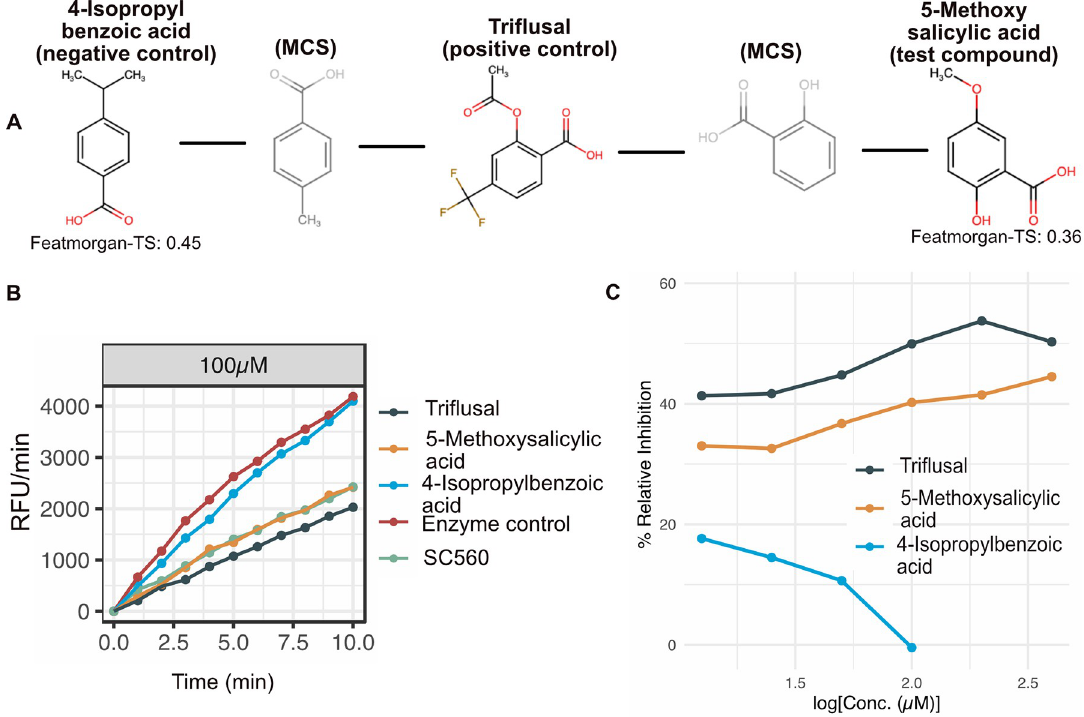
Fig 3. Cox-1 inhibitor assay. (A) Chemical structures of all the tested compounds. MCS structures are also depicted which helped to intuitively assess the structural similarity between the tested compounds (B) An example relative fluorescent units (RFU) plot of the tested compounds at 100 μ M (other tested conc.: 12.5 μ M to 400 μ M serial dilutions). SC560 is a positive control provided by the assay kit supplier (Materials and methods). (C) Relative inhibition of the positive control (drug triflusal), test compound (5-methoxy salicylic acid) and negative control (4-isopropyl benzoic acid) at different tested concentrations. 5-methoxy salicylic acid showed similar inhibition of Cox-1 as the drug triflusal whereas no such inhibition was observed for 4-isopropyl benzoic acid. 4-isopropyl benzoic acid showed strong color change (bright pink) reaction beyond 100 μ M and thus was found unsuitable for being tested at higher concentration with this assay.